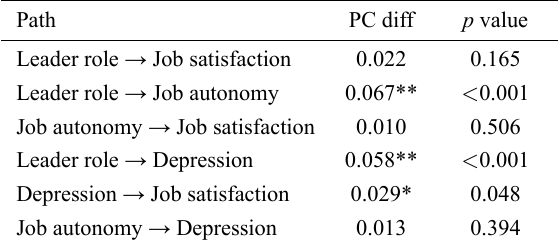
Table 7. Analysis of the difference between the path coefficients of regular and non-regular